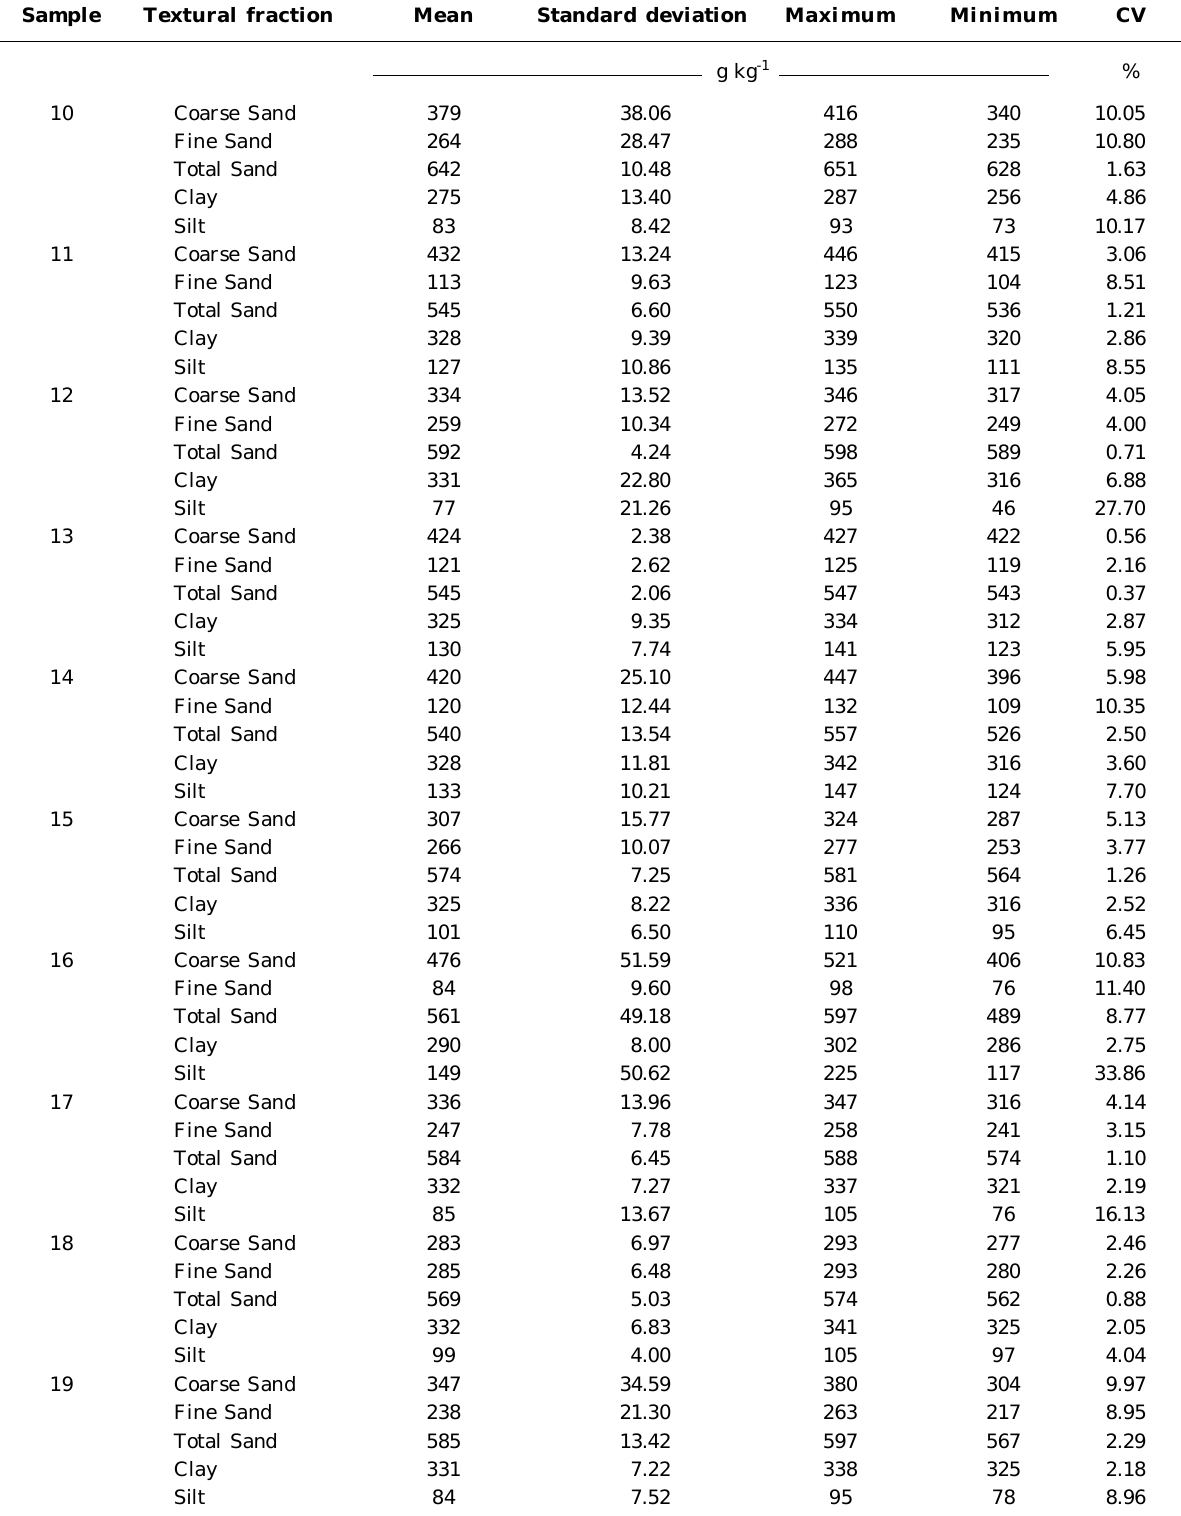
Table 4. Descriptive statistics of the results from particle-size analyses of 21 Medium textured soil samples (n = 4